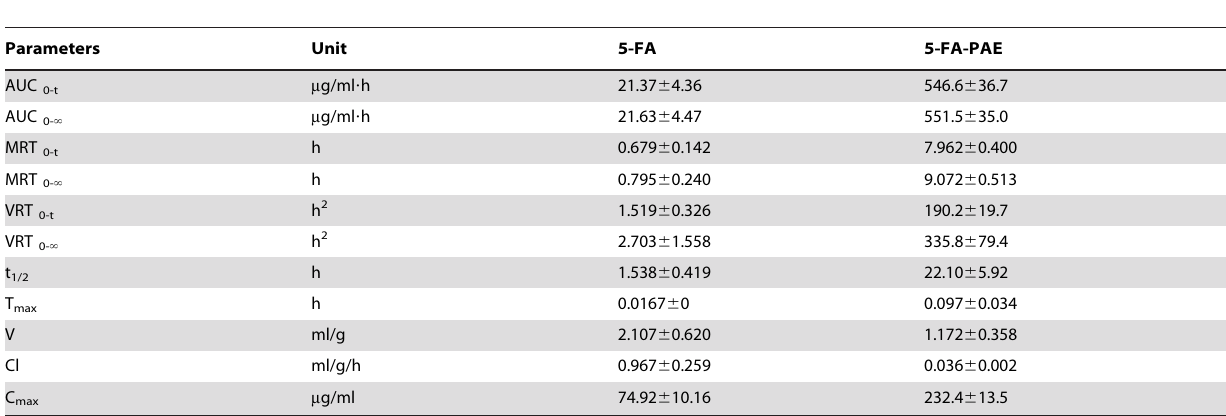
AUC, area under the plasma concentration 2 time curve; MRT, mean residence time; VRT, variance of mean residence time; t 1/2 : elimination half life; T max , time of maximum concentration; V, apparent volume of distribution; CL, clearance; Cmax, the maximum of 5-FA concentration in plasma. Each value represents the mean 6 SD (n=5).